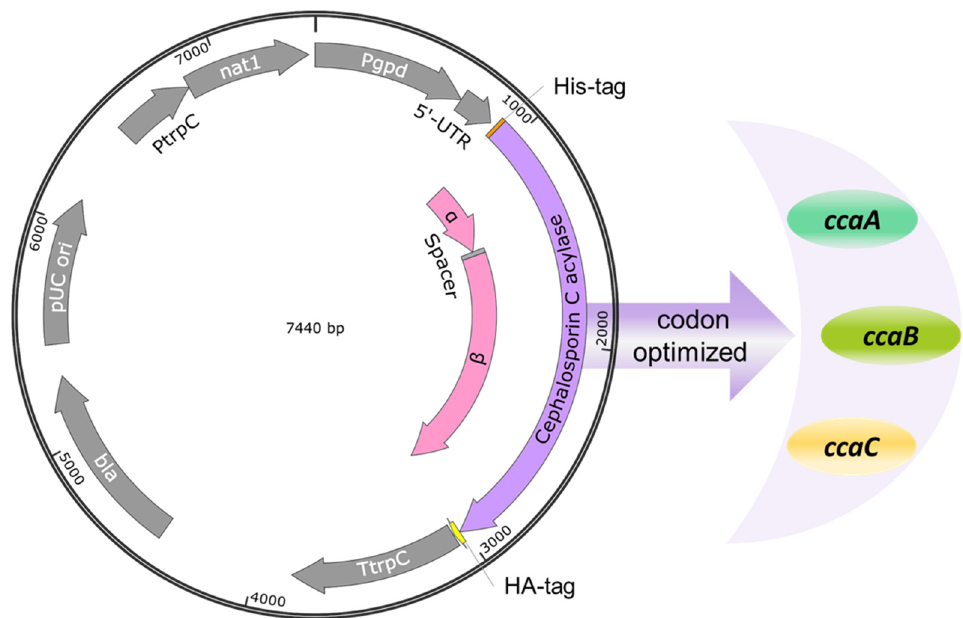
Figure 2. Fungal expression vectors (Table 2) for the recombinant CCA production in A. chrysogenum . Three codon-optimized cca genes ( ccaA , ccaB , ccaC ) were fused 5´ with a Hisx6-tag sequence and 3´with an HA-tag. The cca genes were connected with the tag sequences by GGCGGTGGTGGCTCA-linkers encoding Gly-Gly-Gly-Gly-Ser. The expression of the recombinant proteins was under the control of the constitutive gpdA promoter. The nourseothricin resistance gene served as a selectable marker in fungal transformations.